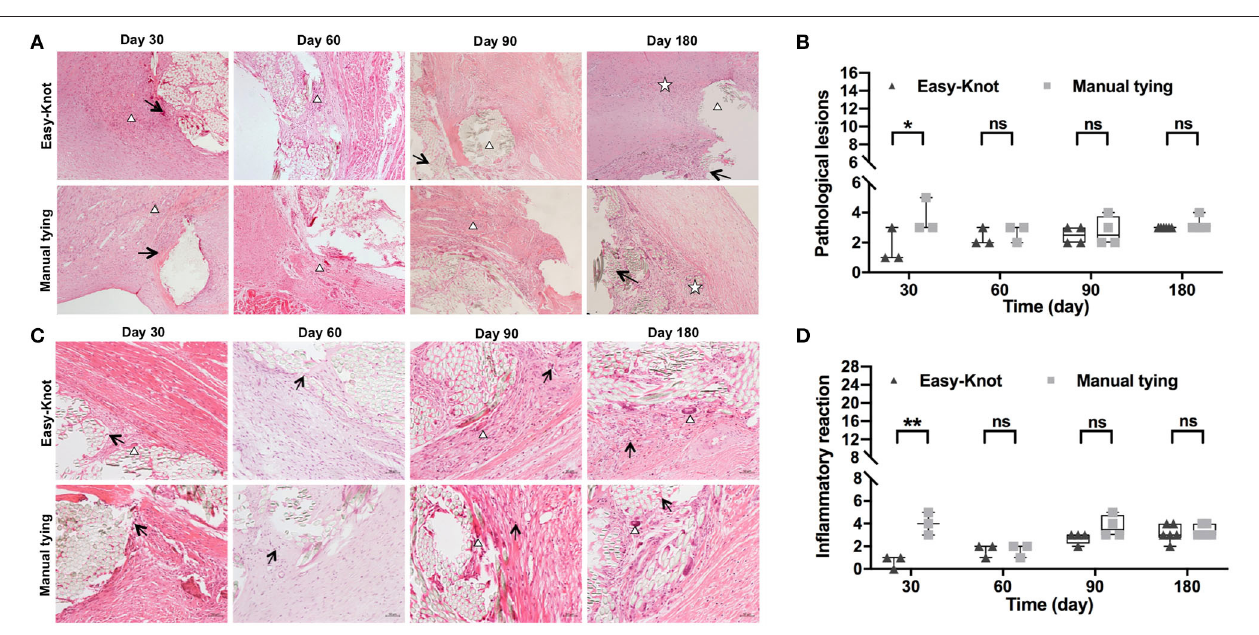
FIGURE 8 | Histopathological examination of tissue around the annuloplasty ring at the indicated time. (A) Histopathological examination showed the typical microstructure of the sutures at indicated time points. 1 , fibrous tissue with granulomatous reaction; ↑ , slight calcification; ☆ , chronic inflammation response. (B) Statistical analyses of pathological lesions. (C) Histopathological examination showed the typical inflammatory cells ↑ , lymphocyte; 1 , monocyte macrophage. (D) Statistical analyses of pathological lesions. * p < 0.05; ** p < 0.01, ns; not